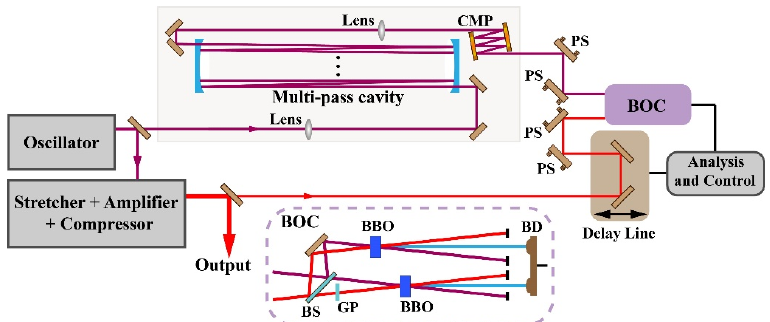
Figure 1. Experimental setup of synchronization system for the oscillator and regenerative ampli- fier. CMP, chirped mirror pair; PS, pointing stabilizer; BOC, balanced optical cross-correlator; BS, beam splitter; GP, glass plate; BBO, β -BaB 2 O 4 ; BD, balanced photodetector. splitter; GP, glass plate; BBO, β -BaB 2 O 4 ; BD, balanced